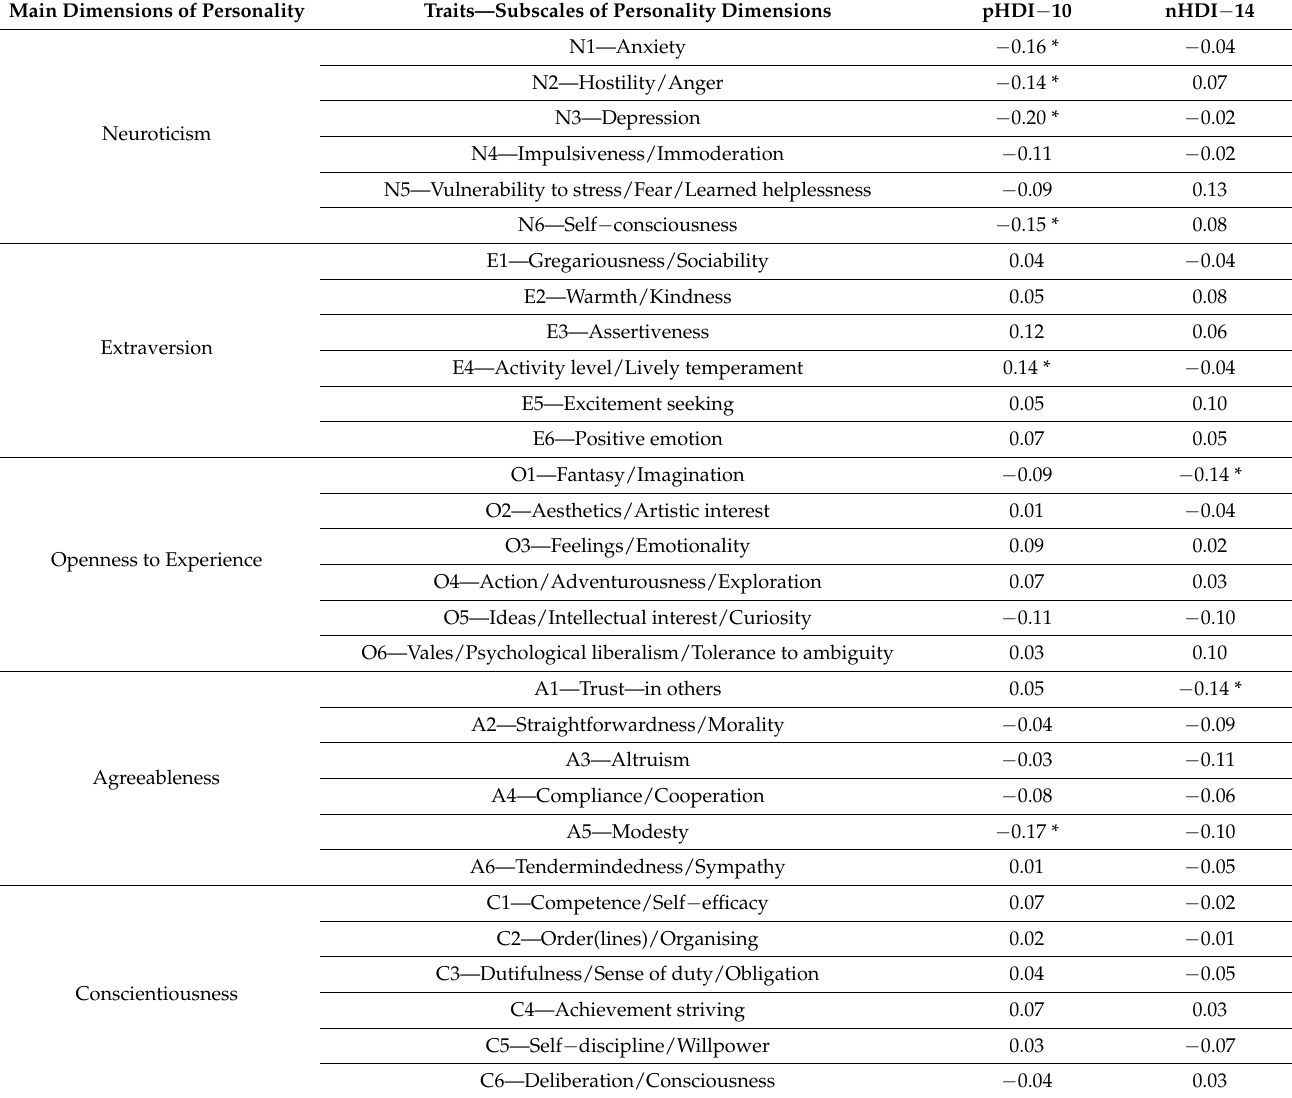
Table 6. Correlations between the subscales of personality dimensions and indices of diet health quality among the studied athletes training team sports (N = 213) (Spearman’s rank coefficient